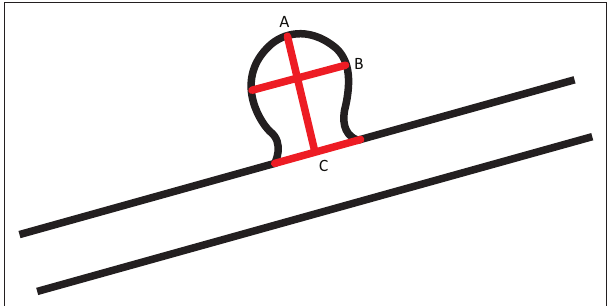
FIGURE 2: Measurement of aneurysms in profile: longitudinal diameter (a) transverse diameter; (b) aneurysm neck (c) at its origin from the parent